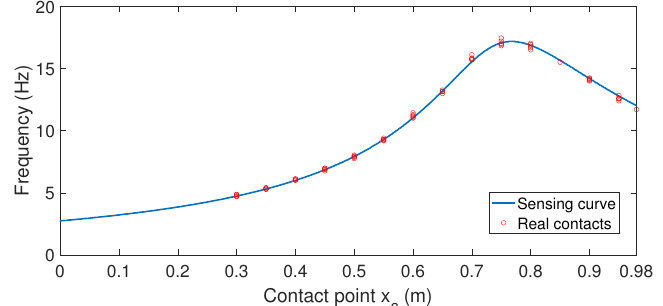
Figure 10. Calibration of the frequency-contact point